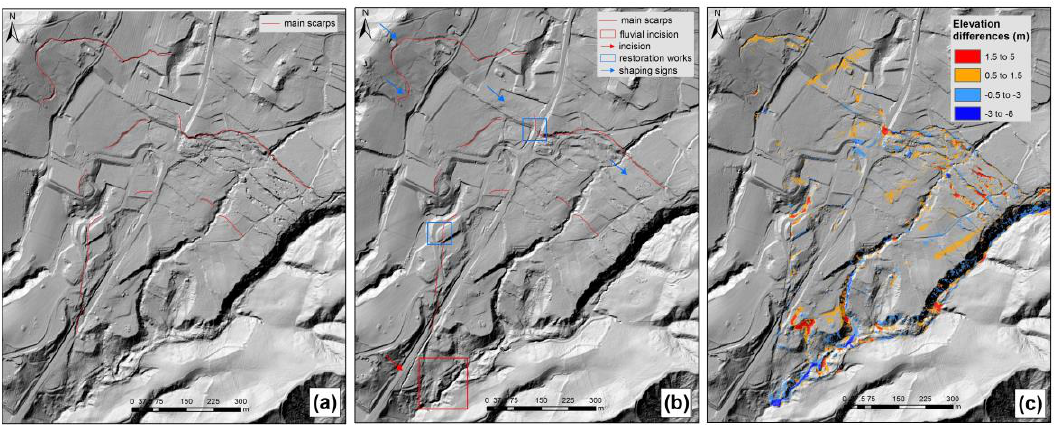
Figure 9. Comparison between two LiDAR DTMs performed post-event, in December 2013 (dec2013DTM) ( a ), and November 2016 (nov2016DTM), with the indication of the main morphological modifications within the landslide area ( b ), and elevation variations occurred in the landslide body until November 2016 ( c ).